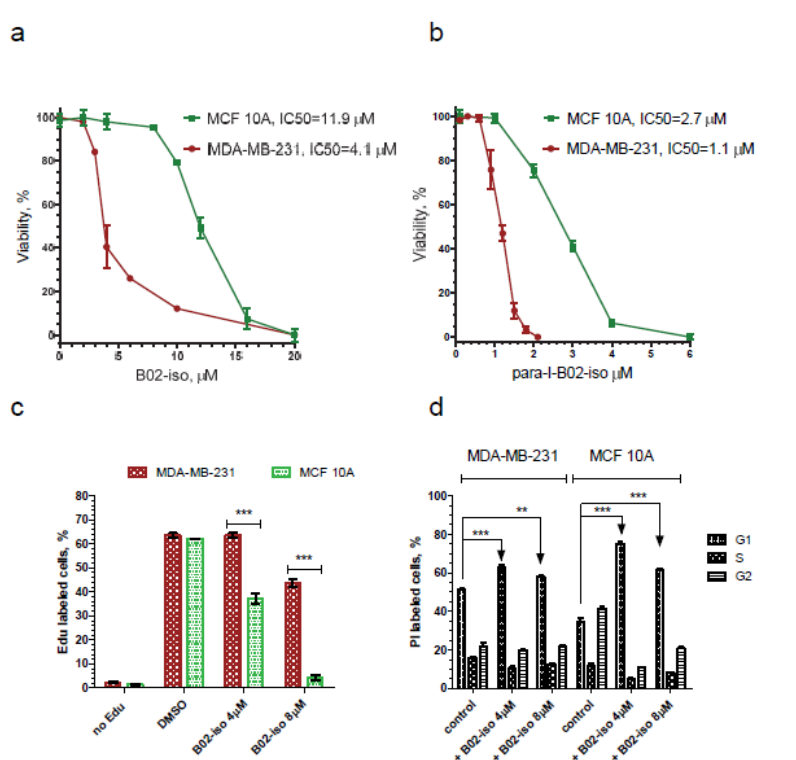
Figure 6. MDA-MB-231 cancer cells show greater sensitivity to B02-iso than breast epithelial MCF 10A cells. Effect of B02-iso ( a ) and para-I-B02-iso ( b ) on the viability of MDA-MB231 breast cancer cells and MCF 10A breast epithelial cells. ( c ) B02-iso halts proliferation in MCF 10A cells but not in MDA-MB-231 cells. ( d ) B02-iso causes prominent G1 cell cycle arrest in MCF 10A cells. Experiments were repeated at least 3 times, and representative graphs are shown. Error bars indicate the SEM, ** p <0.01, *** p < 0.001.